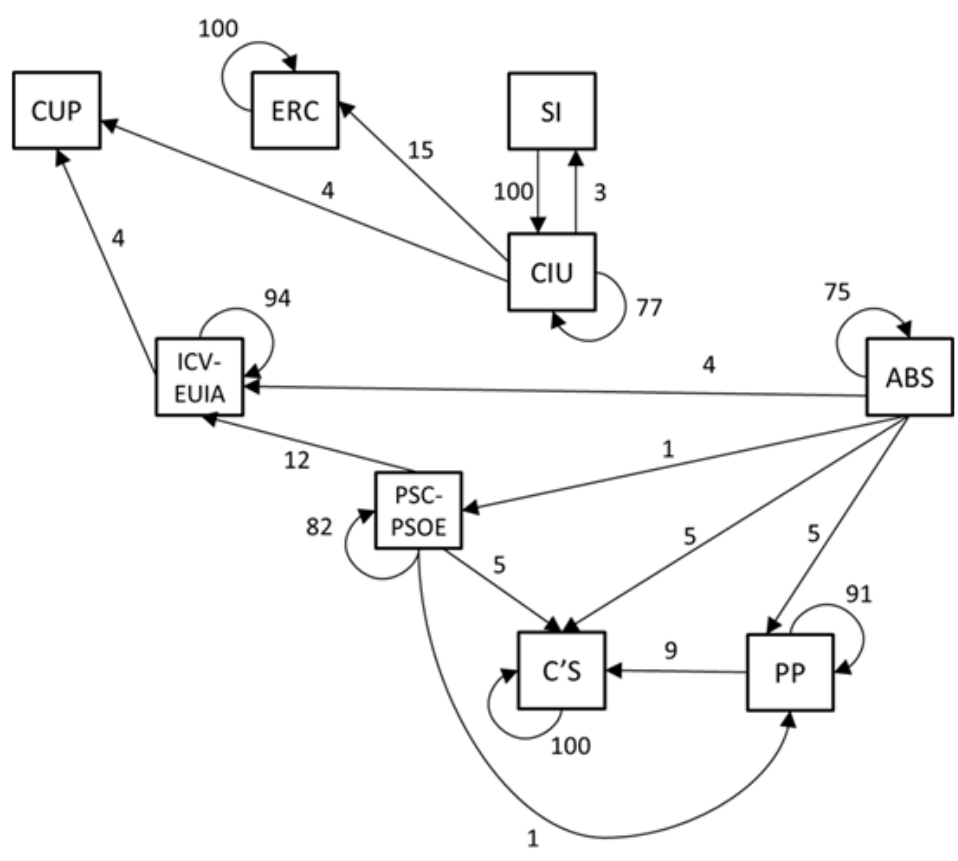
Figure 1. Main flows from 2010 to 2012, given by M1 for the constituency of Barcelona, for the elections to the Catalan Parliament. The numbers next to the arrows are, expressed as a percentage, the corresponding transition rates (those under 1% are omitted). All the options represented in the figure, including abstention and with the exception of CiU, also receive flows from a certain number of minor